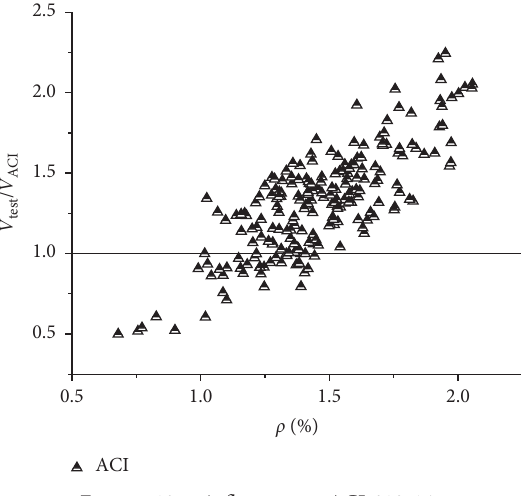
Figure 12: ρ influence on ACI 318-14.